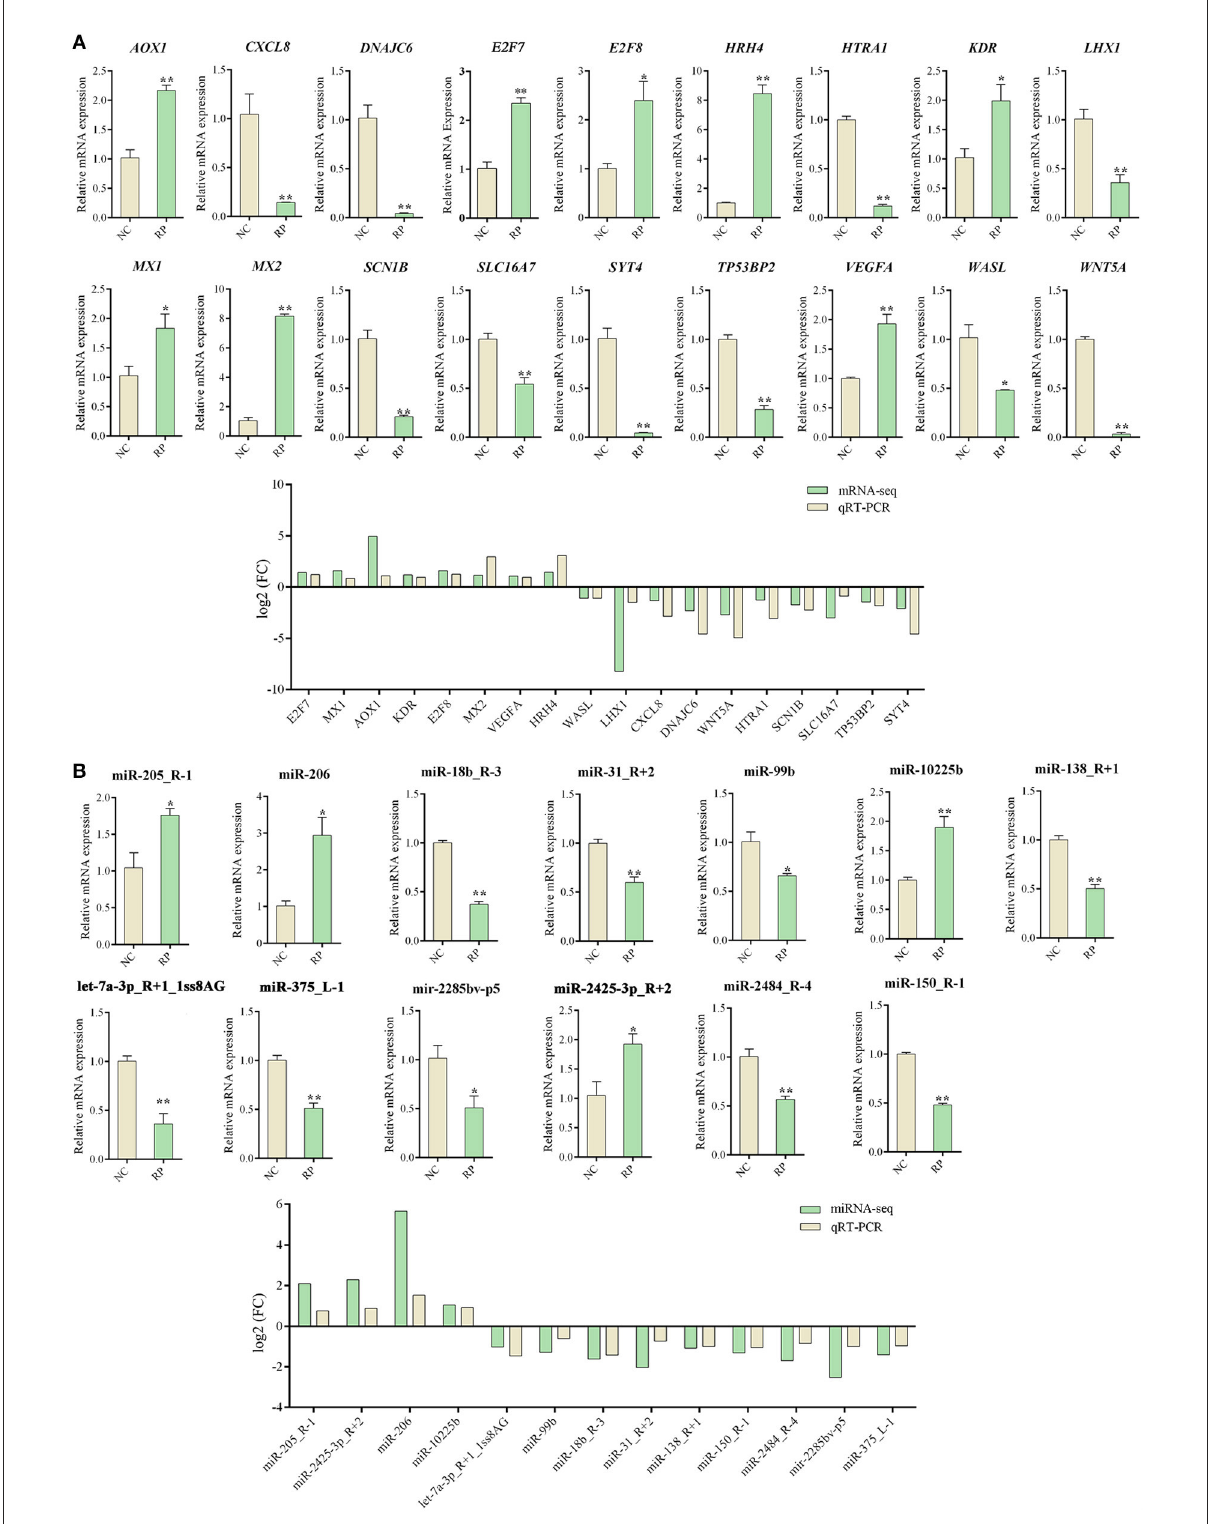
FIGURE4 qRT-PCR Validation of DE genes in NC and RP. (A) qRT-PCR analysis of DE mRNA expression and comparison of |log2 FC| expression levels of mRNA-seq and qPCR. (B) qRT-PCR analysis of DE miRNAs expression and comparison of |log2 FC| expression levels of miRNA-seq and qRT-PCR. Data represent the mean ± SEM. * p < 0.05, ** p < 0.01. FC, fold-change; qRT-PCR, quantitative reverse transcription PCR; NC, fetal membranes of normal discharge; RP, retained